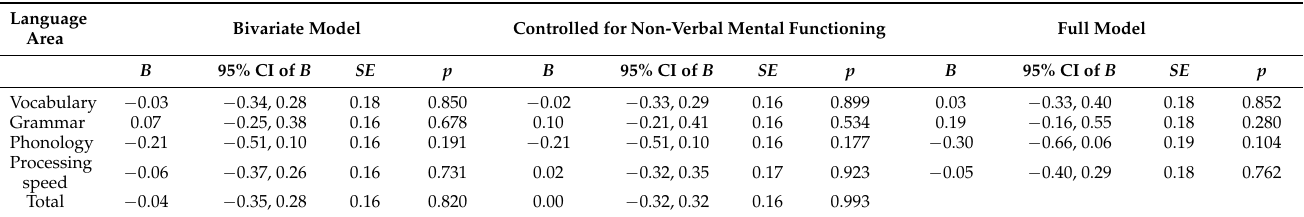
Table 4. Association between difficulties with fluency and the gap between receptive and expressive skills in various language areas ( N =